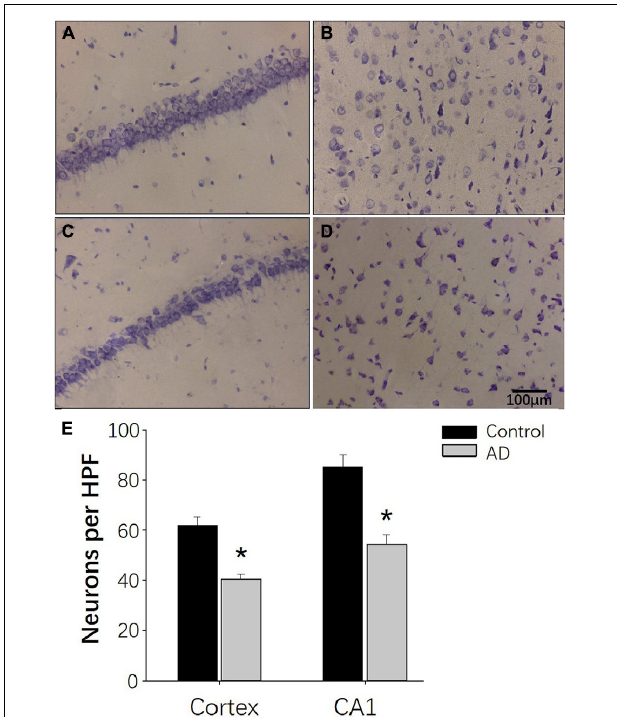
FIGURE 8 | Nissl staining demonstrating the decreased neurogenesis in AD rats at 28 days after A β 25–35 administration. (A,B) Representative photomicrographs of the hippocampal CA1 region (A) and the internal pyramidal layer of parietal cortex (B) in control rats demonstrating normal neural cytoarchitecture. (C,D) Representative photomicrographs of the hippocampus CA1 region (C) and the internal pyramidal layer of the parietal cortex (D) in the AD group, demonstrating reduced numbers of neurons and neural damage. (E) Bar chart presenting the number of neurons per HPF in the internal pyramidal layer of parietal cortex and hippocampal CA1 area of AD and control group. n = 6 per group, * p < 0.05, scale bar = 100 µ